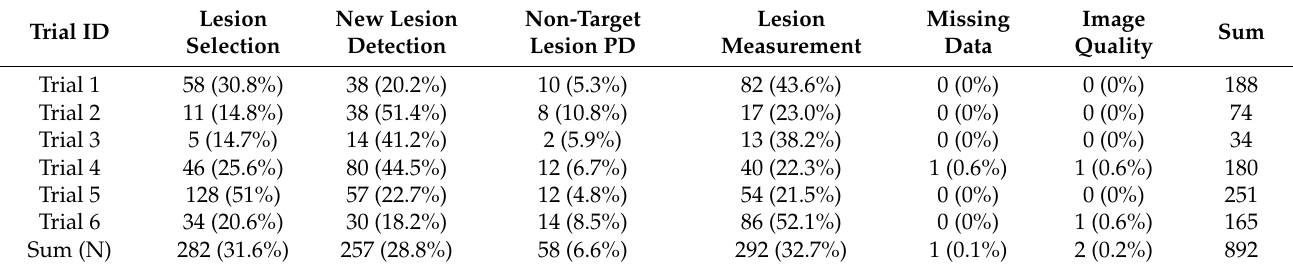
From left to right: number of time points (TPs) reviewed in the trial; rate of any RTPR discordance at the study level (independently of the study patients belonged to); number of patients included in the trial; rates of patient discordance with at least one RTPR discordant at any TP; rate of patient discordance (DOP only); average number of TPs per patient in the trial. When applicable, the corresponding 95% CI is shown in brackets. Table 3. Distribution of the causes of adjudication. Raw numbers and proportions relative to the total numbers in the trials (%). Adjudications were documented by adjudicators, and adjudication paradigms are trial-specific. Trial